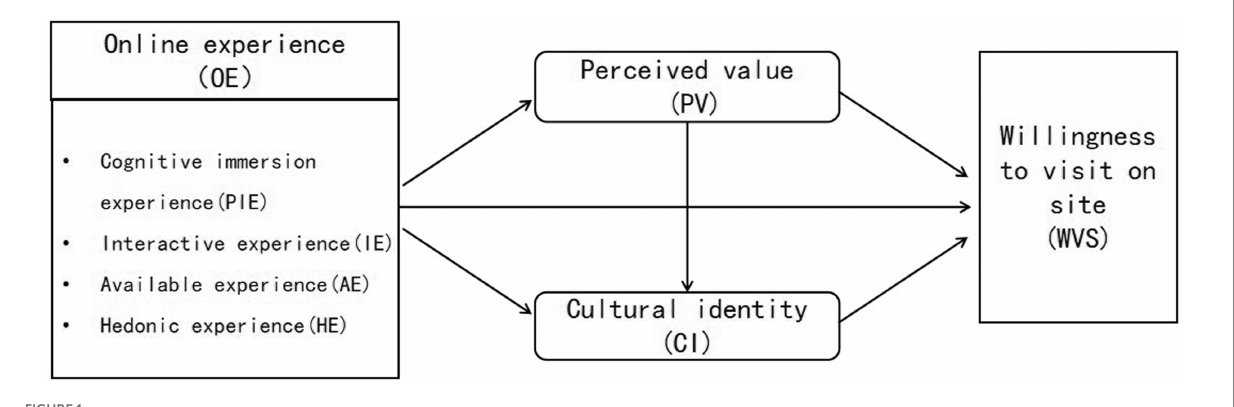
FIGURE 1 Theoretical